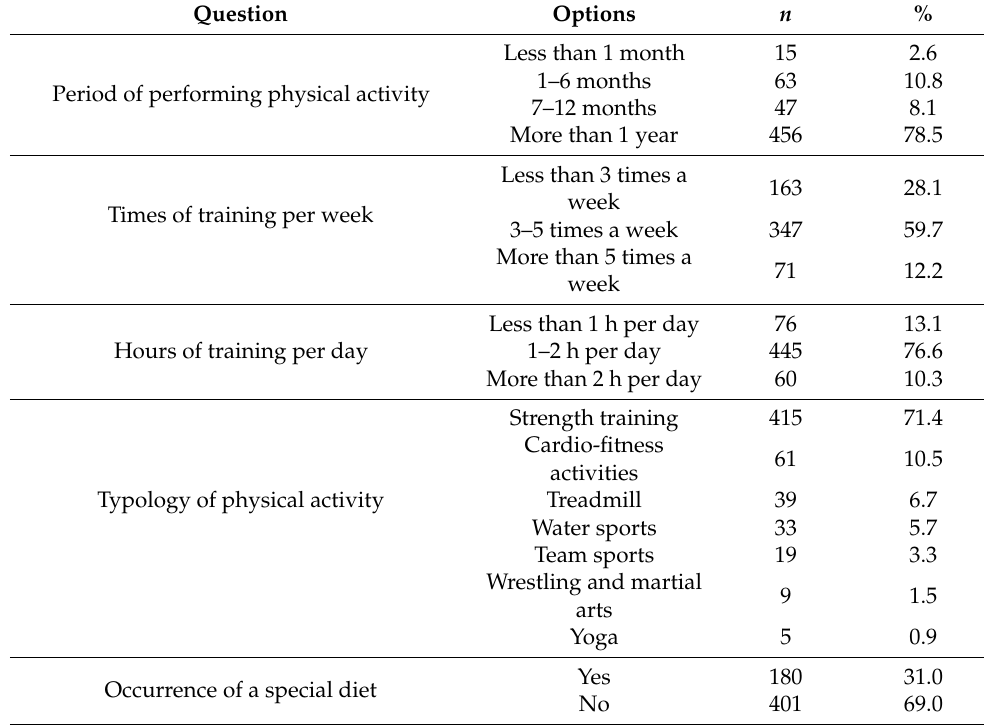
Table 2. Characterization of the sample in terms of typology and timing of sports and diet